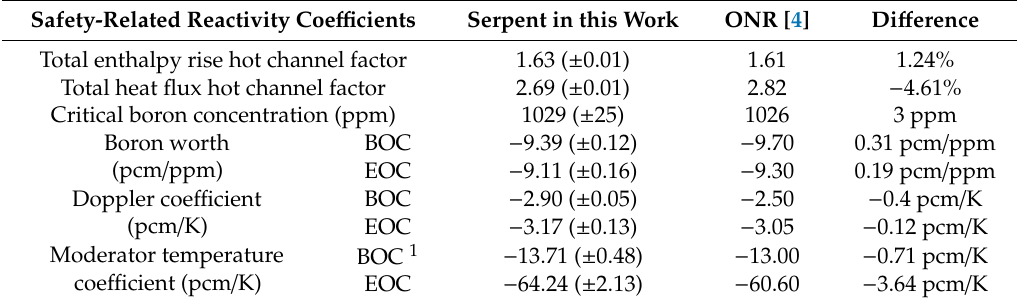
Table 4. EPR full-core reactivity coe ffi cients and hot channel factors benchmark (cycle 1, HFP, RCCA out): Serpent Monte Carlo (this work) vs. deterministic codes sequence by the UK O ffi ce for Nuclear Regulation